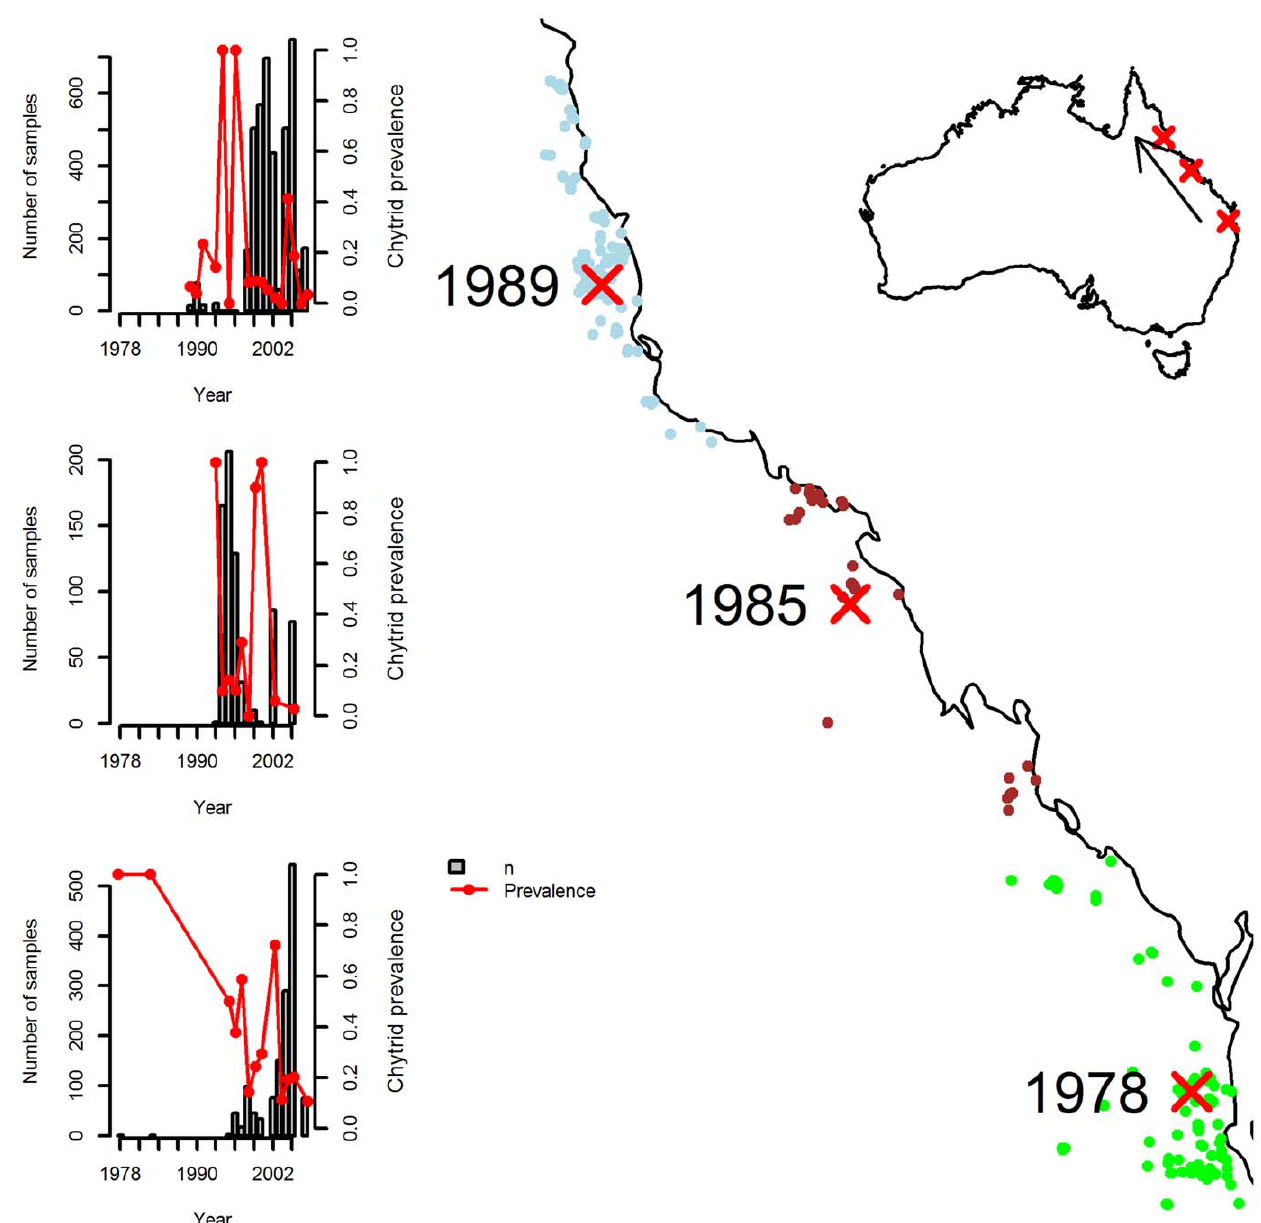
Figure 2. Distribution of localities sampled for Bd along the north-east coast of Queensland, Australia. Decline localities are marked with a large red cross and labelled by their approximate date of amphibian population decline. Left-hand-side inset panels show sample sizes (grey bars) and prevalence (red series) by year for data aggregated around each of the decline localities. Note that earliest samples indicate the presence of Bd, and that there are no earlier samples indicating its absence.